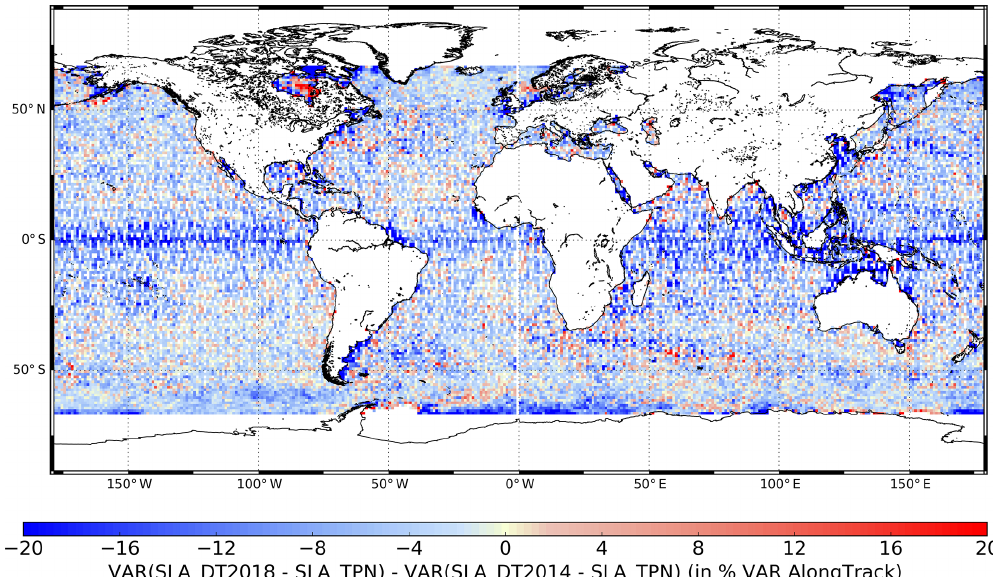
Figure 5. Difference of the RMS of the difference between gridded SLA products and independent TOPEX–Poseidon interleaved along-track SLA measurements successively using the DT2018 and DT2014 versions. Negative values represent reduced differences between DT2018 altimetry products and independent along-track